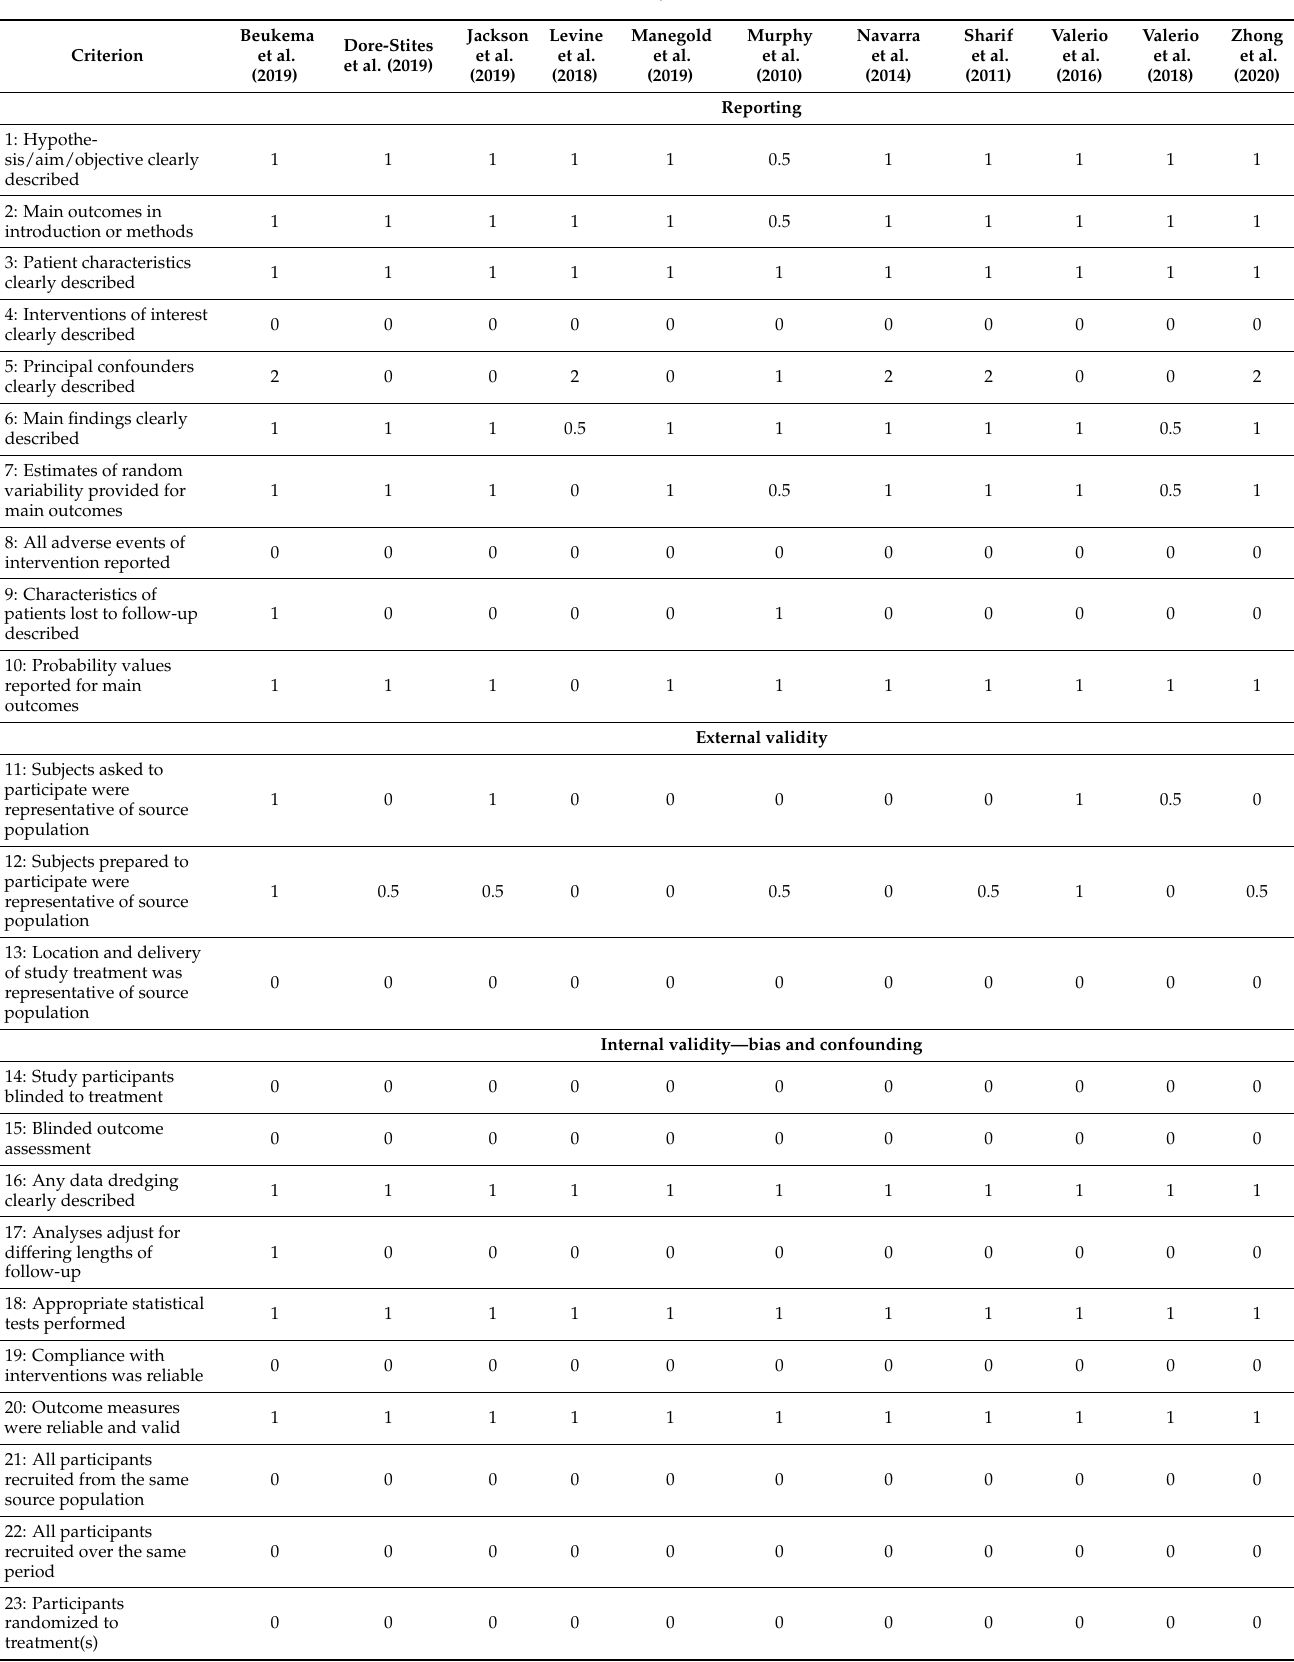
Table A2. Quality